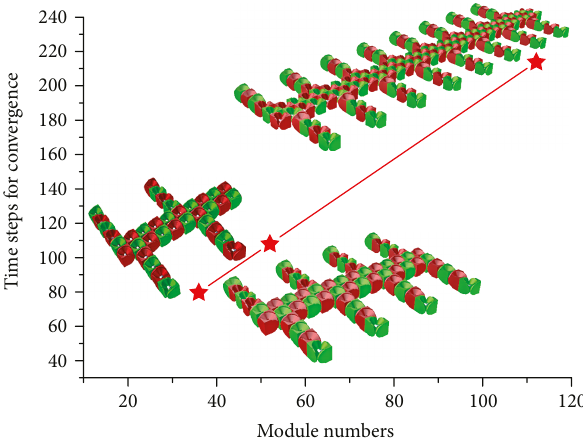
Figure 12: scalability to module numbers through